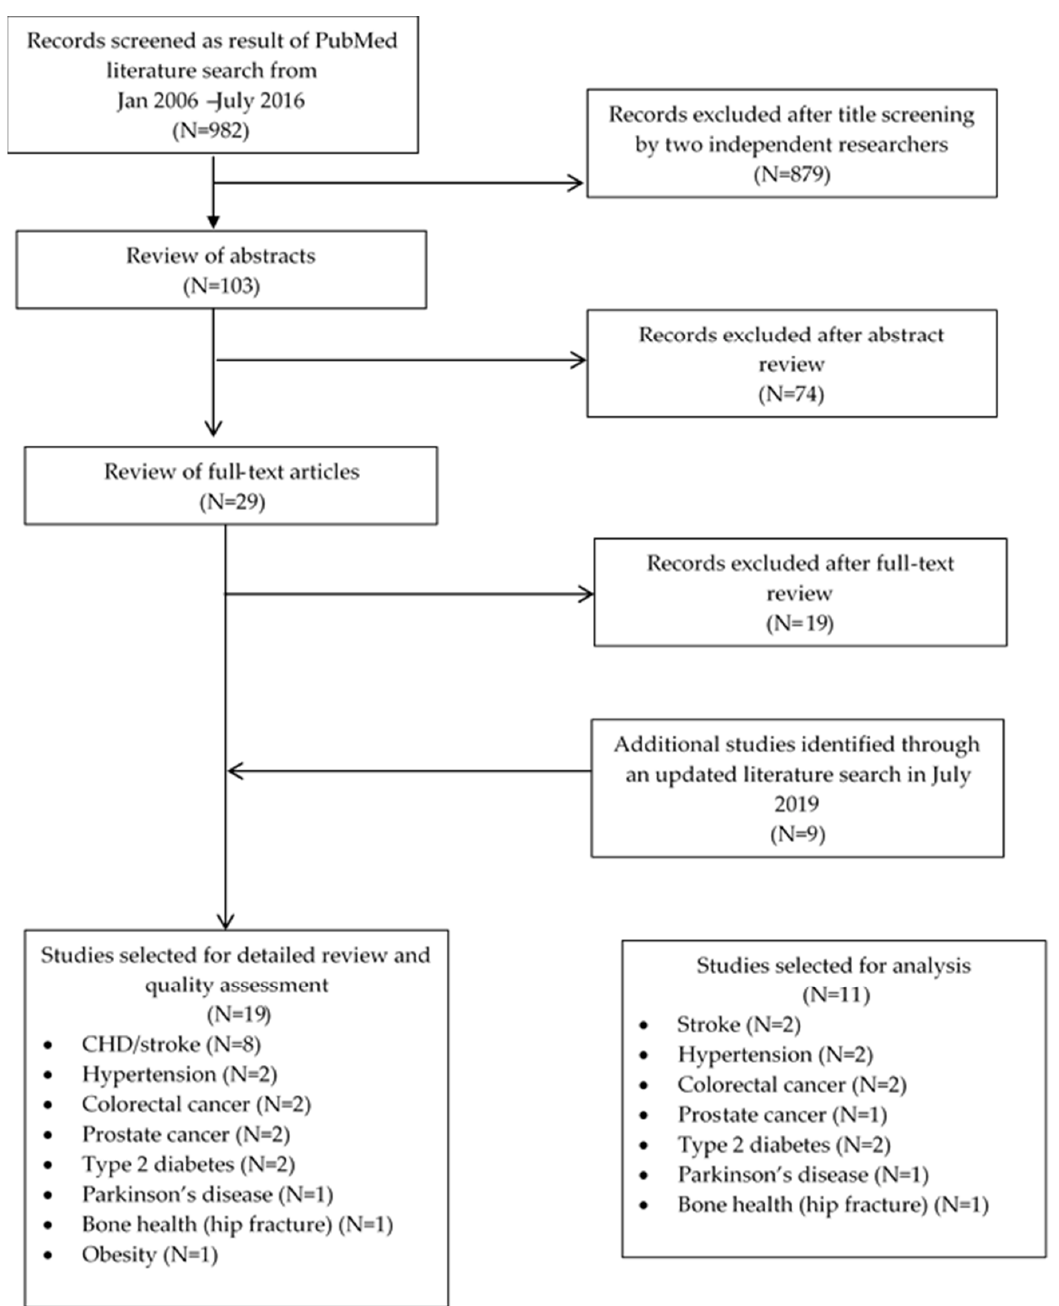
Figure 2. Study selection flow chart for review of published meta-analyses measuring the association between dairy consumption and chronic health